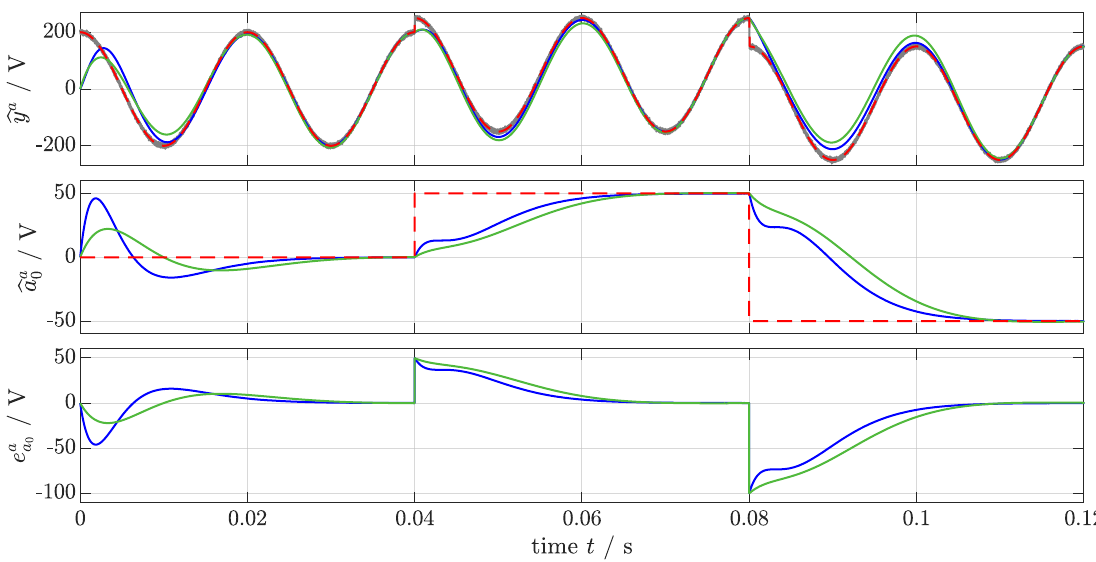
Figure 6. Simulation results for Scenario (S2): Noisy input y a ( ), noise-free input y a DC-offset a a 0 ( ), its estimates (cid:98) y a & (cid:98) a a 0 and DC-offset estimation error e a a